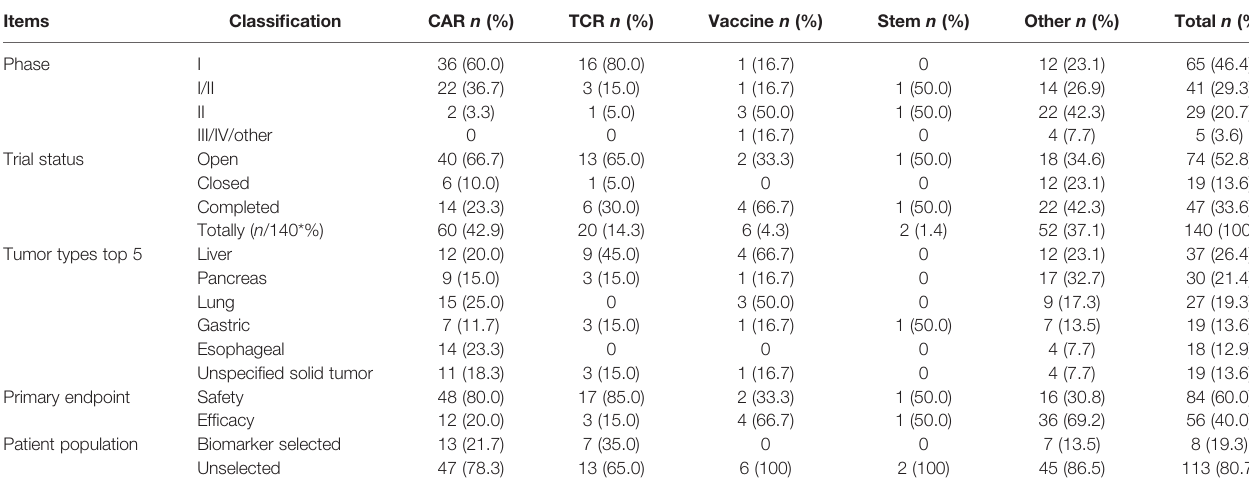
TABLE 3 | Classi fi cation and characteristics of clinical trials on cell therapy in China. Items